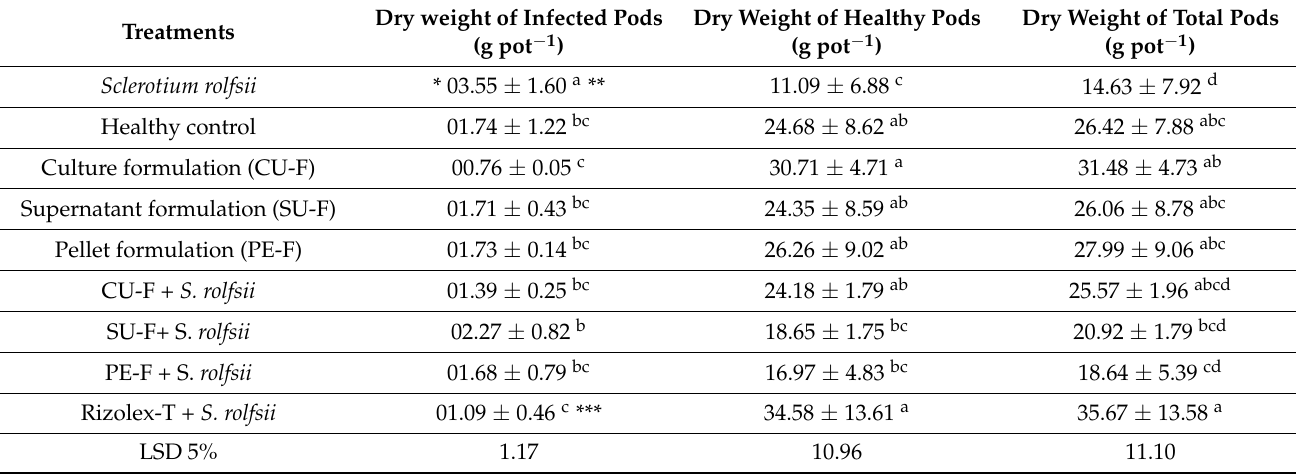
Table 4. Effect of treatment with talc-based formulations of Streptomyces cellulosae Actino 48 on peanut yield under artificial infection and greenhouse